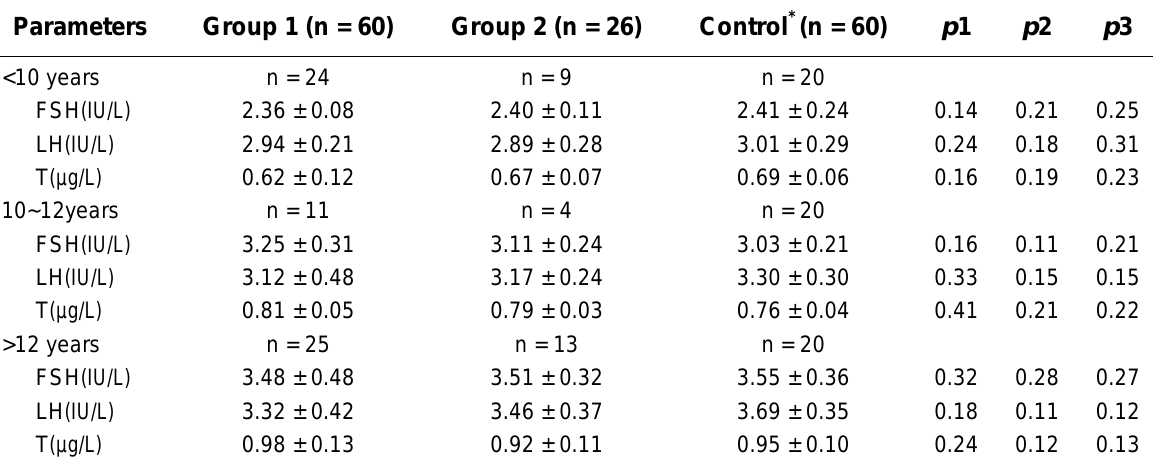
the Control Group